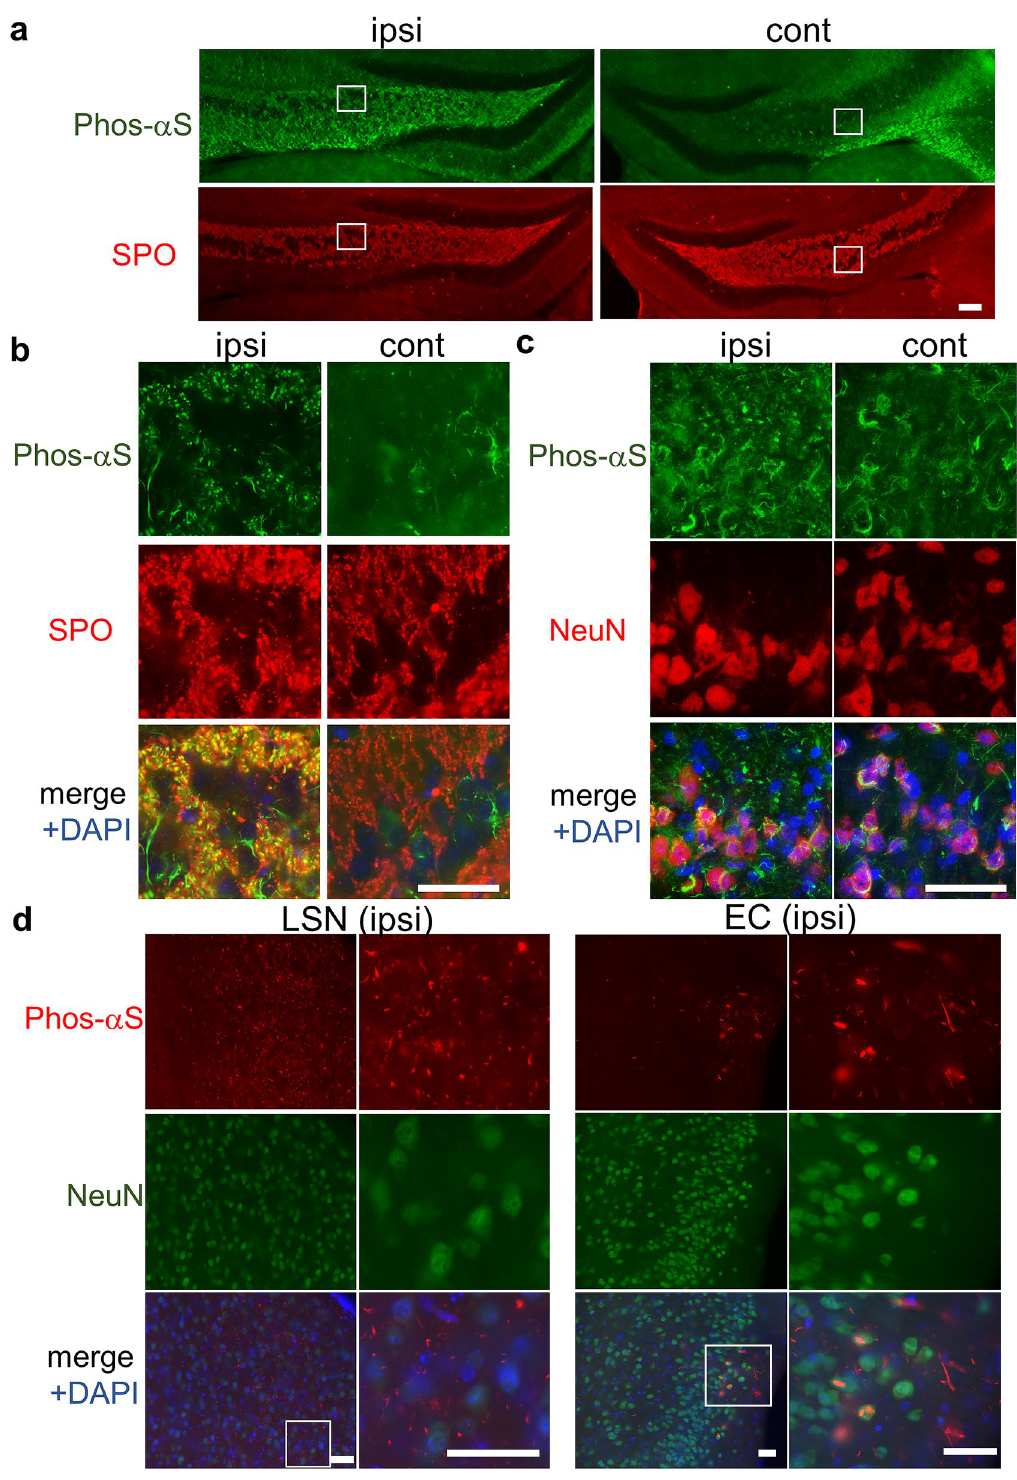
Figure 4. Difference in appearance of seed-dependent phosphorylated α-synuclein between the ipsilateral and contralateral sides. ( a , b ) Appearance of phosphorylated α-synuclein (Phos-αS) in the dentate gyrus (DG) and CA3 regions of the ipsilateral (ipsi, left) and contralateral (cont, right) sides. At 14 days after the injection, mice were sacrificed and the brains were fixed. Slices were double- stained with anti-phosphorylated α-synuclein and anti synaptoporin (SPO) antibodies. Images show phosphorylated α-synuclein (upper, green) and synaptoporin (lower, red). Magnified images of the regions surrounded by white rectangles are shown in b. The merged images with DAPI (blue) are also shown. ( c ) Slices were double-stained with anti-phosphorylated α-synuclein and anti NeuN antibodies. Images show phosphorylated α-synuclein (green), NeuN (red), and the merged image with DAPI (blue). ( d ) Appearance of phosphorylated α-synuclein in the lateral septal nucleus (LSN, left) and the entorhinal cortex (EC, right) regions. Images show phosphorylated α-synuclein (red), NeuN (green), and the merged image with DAPI (blue). Regions surrounded by white rectangles in merged images are magnified and shown in the rightmost panel of each lane. Scale bars, 100 μm ( a ), 50 μm ( b , c and d